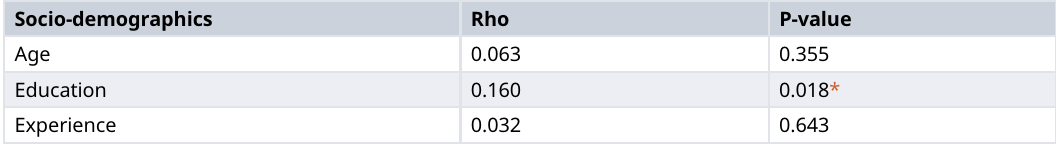
Table 8. Correlation between the practice and socio-demographics of dental auxiliaries